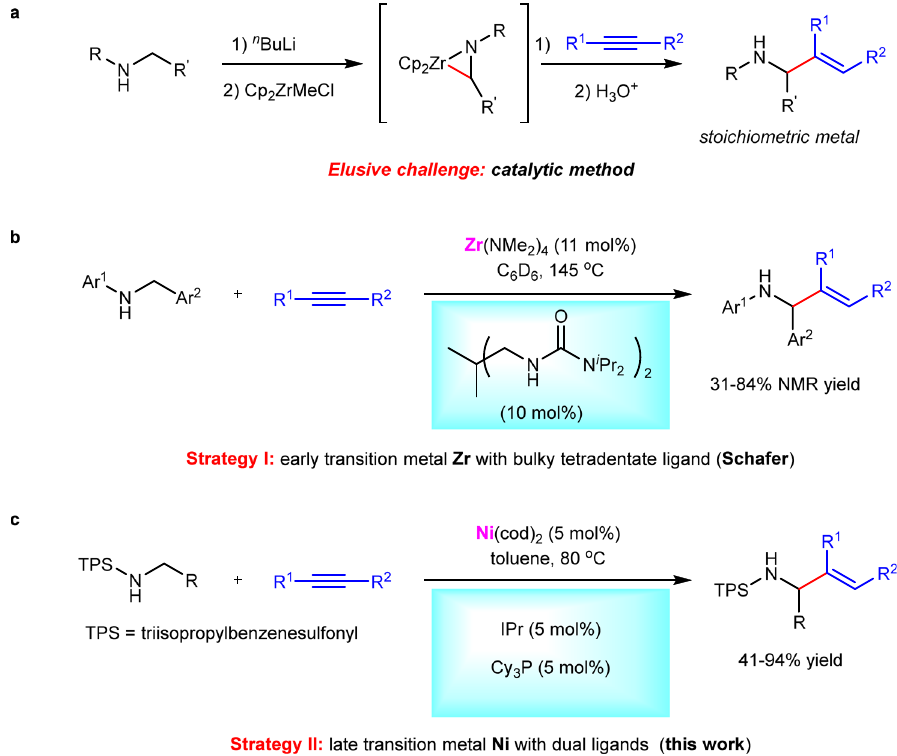
Fig. 1 Transition metal-catalyzed hydroaminoalkylation of alkynes. a Pioneering investigation using stoichiometric Zr-complex (Buchwald). b Strategy I using early transition metal Zr and bulky tetradentate ligand (Schafer). c Strategy II using late transition metal Ni with dual ligands (this work). IPr = 1,3-bis (2,6-diisopropylphenyl)-2,3-dihydro-1 H -imidazole. Cy 3 P =